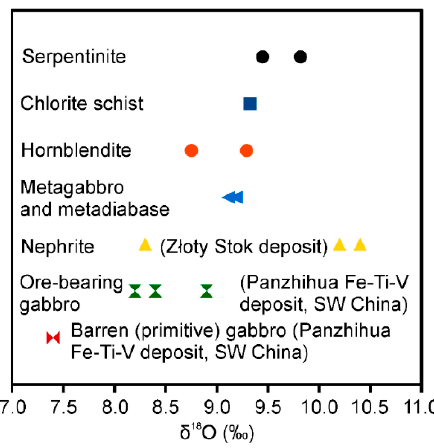
Figure 12. The oxygen isotope composition ( δ 18 O) of silicate minerals separates. The dolomitic marble-hosted nephrite from the Z ł oty Stok deposit is presented after Gil et al. [31] and the Panzhihua Fe-Ti-V deposit after Ganino et al. [64].